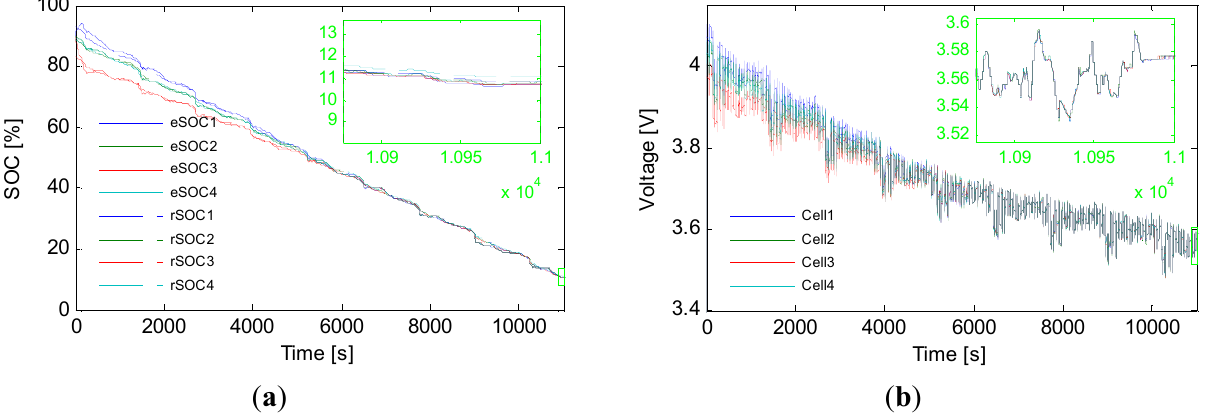
Figure 12. The Results of the experiment in situation 2: ( a ) SOC balancing results; ( b ) Voltage